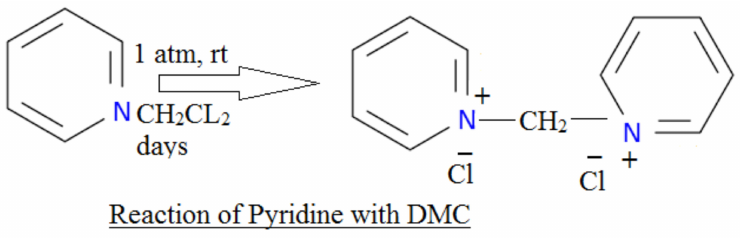
Figure 5. Representation of reaction of pyridine with